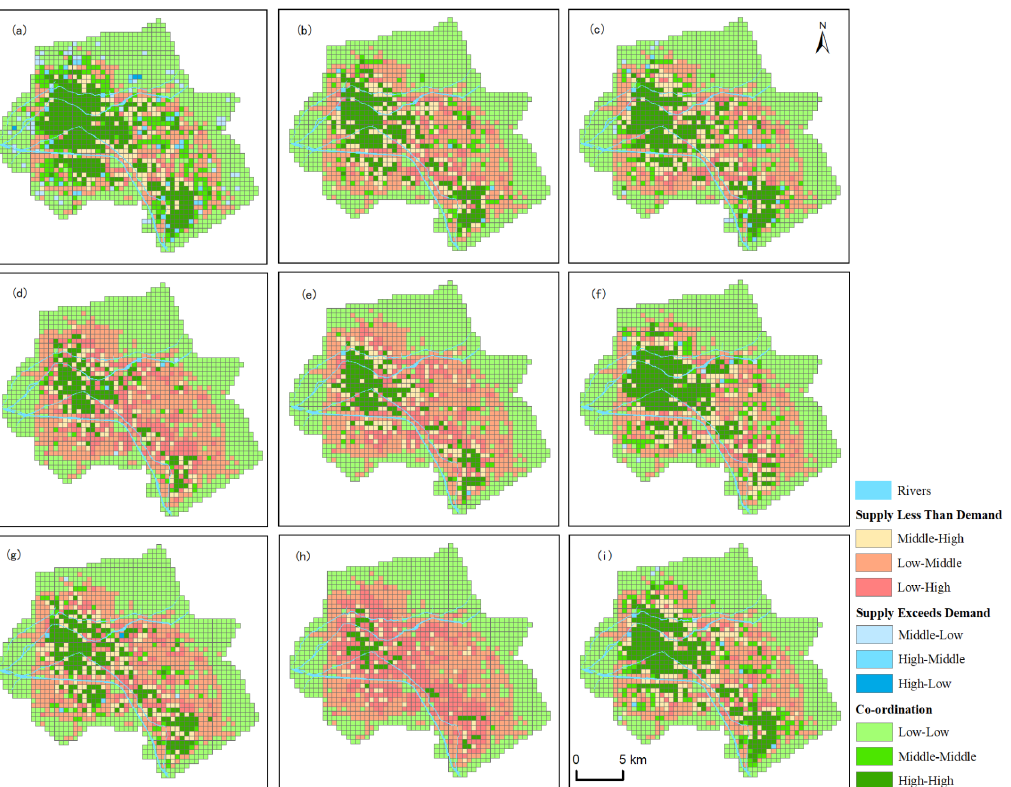
Figure 5. Spatial distribution of supply–demand relationship of amenities. ( a ) the distribution of the supply–demand relationship for all amenities; ( b ) the distribution of the supply–demand relationship for amenities of food; ( c ) the distribution of supply–demand relationship for amenities of shopping; ( d ) the distribution of supply–demand relationship for amenities of leisure; ( e ) the distribution of supply–demand relationship for amenities of health; ( f ) the distribution of supply– demand relationship for amenities of transportation; ( g ) the distribution of supply–demand relationship for amenities of education; ( h ) the distribution of supply–demand relationship for amenities of finance; ( i ) the distribution of supply–demand relationship for amenities of life services.